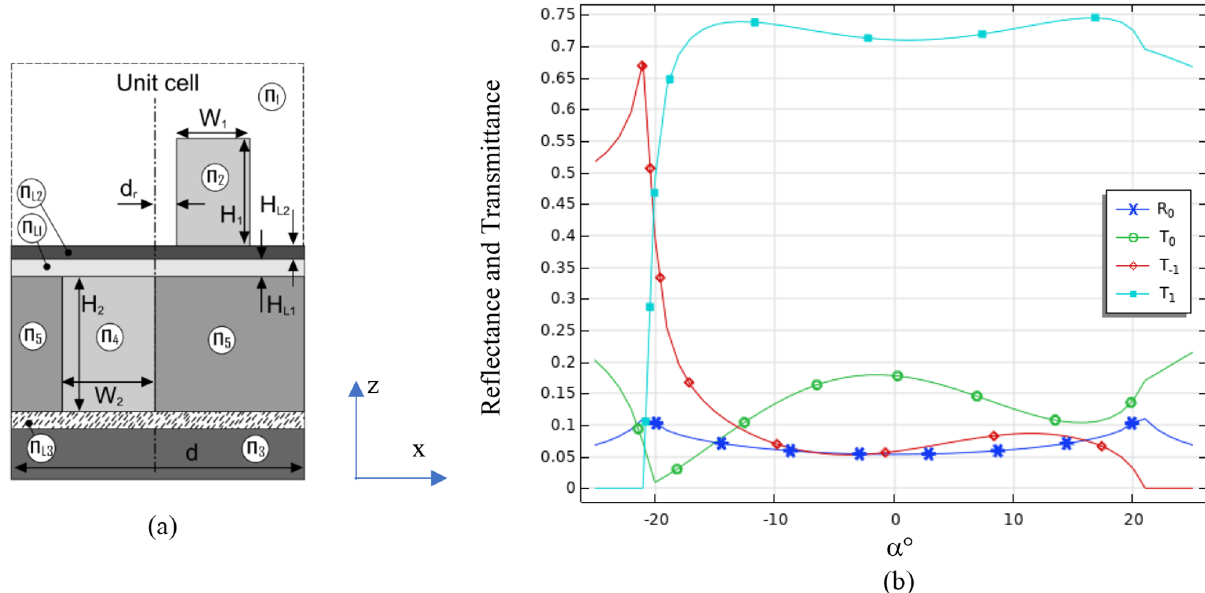
Fig. 6. (a) Cross-sectional view of transmissive grating unit cell; (b) re fl ectance and transmittance vs. angle of TE-polarized electromagnetic wave incidence a at λ =625nm, n 1 =1.0, n 2 = n 4 = n L1 =2.5884, n 3 =1.7, n L2 =1.7663, n 5 =1.4572 for TiO 2 transmissive grating with such parameters: